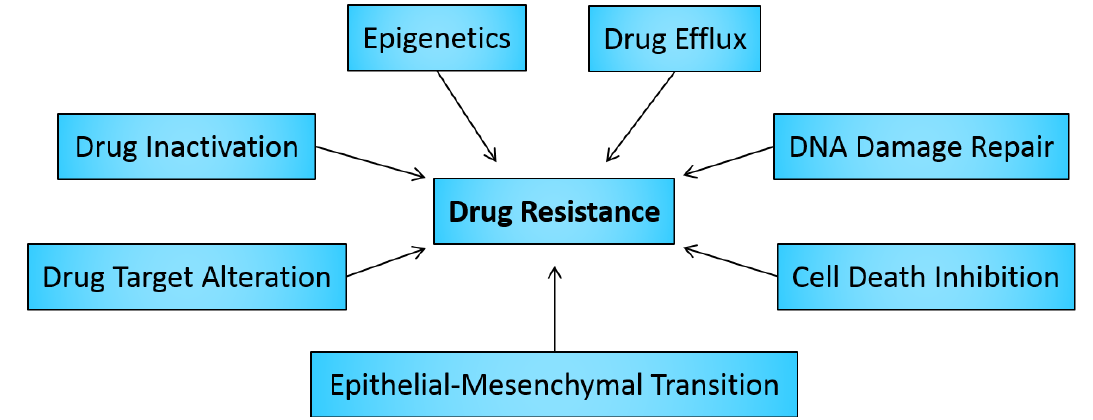
Figure 1. Categories of mechanisms that can enable or promote direct or indirect drug resistance in human cancer cells. These mechanisms can act independently or in combination and through various signal transduction